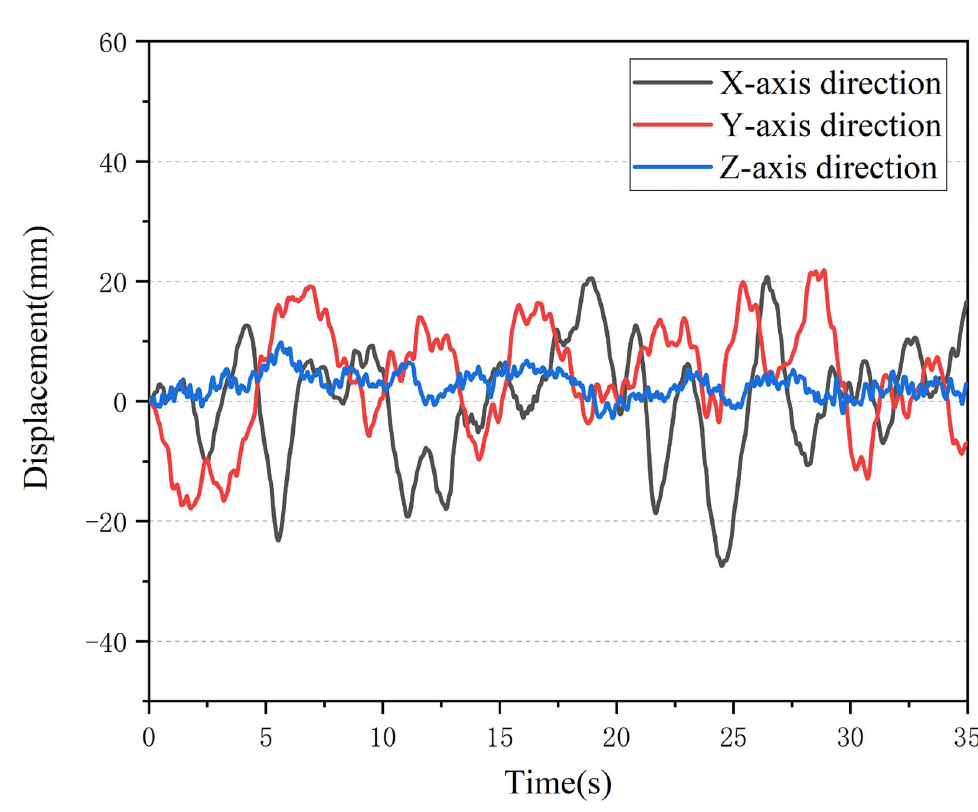
Fig 3. Displacement change curve.